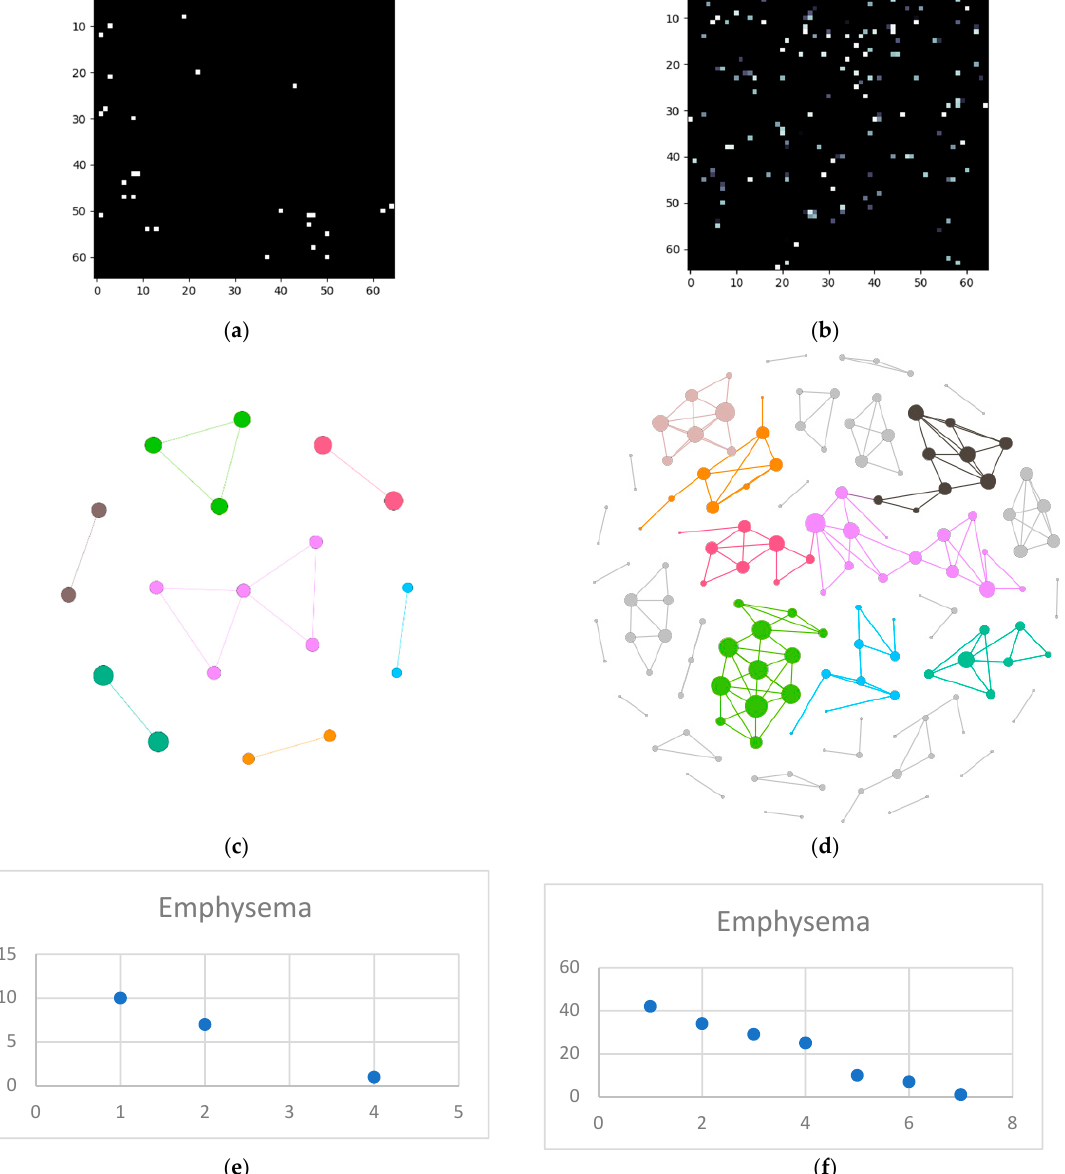
Figure 5. Emphysema processing ( a ) HU filtered layer for the normal sample; ( b ) HU filtered layer for the DILD sample ( c ) Complex network built according to the proposed algorithm corresponding to the normal sample, Fruchterman–Reingold render layout, node sizes proportional to node degrees, edge width invariant (1.5 pixels). ( d ) Complex network built according to the proposed algorithm corresponding to the DILD sample, Fruchterman–Reingold render layout, node sizes proportional to node degrees, edge width invariant (1.5 pixels). ( e ) Degree distribution of the normal sample network ( f ) Degree distribution of the DILD sample